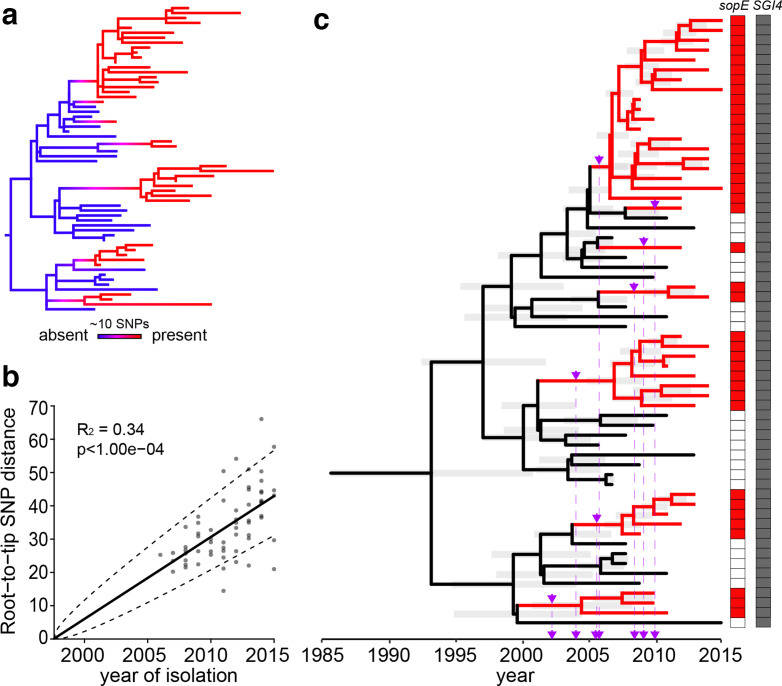
Ancestral state reconstruction of sopE with time-scaled phylogeny. Variation in the whole-genome sequences of S. Typhimurium isolated from UK pigs between 2006 and 2015 was used for ancestral state reconstruction and time-scaled phylogenetic trees. (a) ML phylogenetic tree based on recombination-purged variation in the core-genome sequence showing the reconstruction of the ancestral character state of sopE. The colour gradient displays the probability associated with sopE presence/absence inferred from 500 simulations. The number of SNPs (~10) is indicated by the length of the bar, and was estimated from the genetic distance as a proportion of SNP sites used to reconstruct the tree. (b) Root-to-tip regression analysis assessing the presence of a significant temporal signal within the isolate collection. The plot shows the correlation between the number of SNPs accumulated and the year of isolation, which was statistically significant (P value 0.0001). The coefficient of determination (r2), which indicates how well the model fits the data and reflects the among-lineage rate variation, was 0.34. (c) Dated phylogenetic tree inferred from the ML phylogenetic tree in (a) showing the events of sopE acquisition (purple arrows).